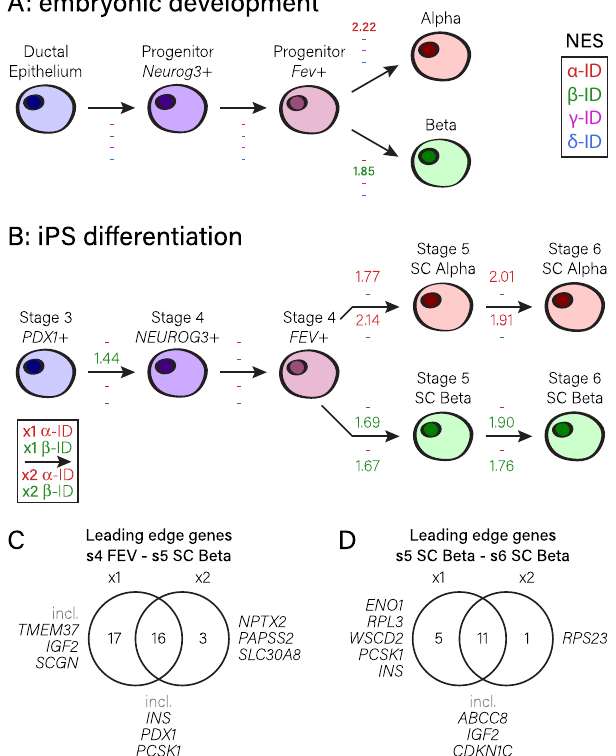
Fig. 5 Assessing plasticity in α - and β -cell identity during embryonic development, pluripotent cell differentiation, cell type interconversion and in diabetes. Changes in α -, β -, γ - and δ -cell identity were measured between states during murine embryonic pancreas development ( A ) and in different human ES/iPS cell differentiation protocols (x1 and x2; B ). Arrows indicate progression. Values in red, green, magenta and blue indicate normalized enrichment scores from GSEA for α -ID, β -ID, γ -ID and δ -ID genesets, where positive values indicate a gain in identity and negative values indicate a loss of identity; scores indicated by – are not signi fi cant (FDR higher than 0.05). C , D Venn diagrams indicating differences in leading-edge genes (genes responsible for the correlation between a geneset and the observed increase in β -cell identity) between the x1 and x2 protocols. Differences in leading-edge genes from stage 4 FEV expressing cells to stage 5 SC- β cells ( C ) and from stage 5 to stage 6 SC- β cells ( D